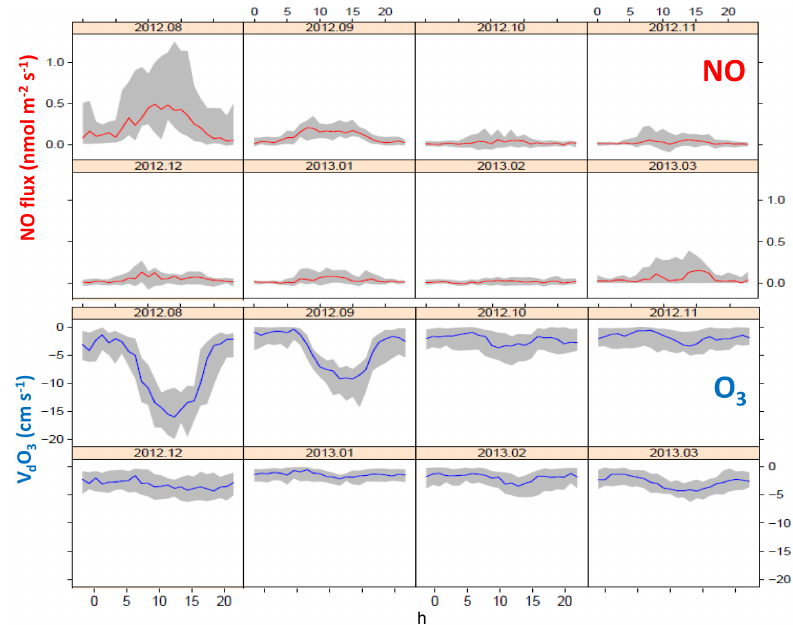
Figure 5. Seasonal changes of ozone deposition velocity V dO